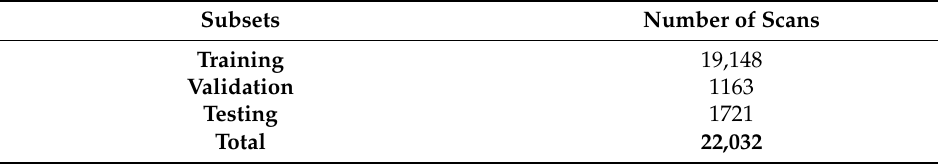
Table 2. Number of cases in each subset from the (BCS-DBT) dataset [29–31].